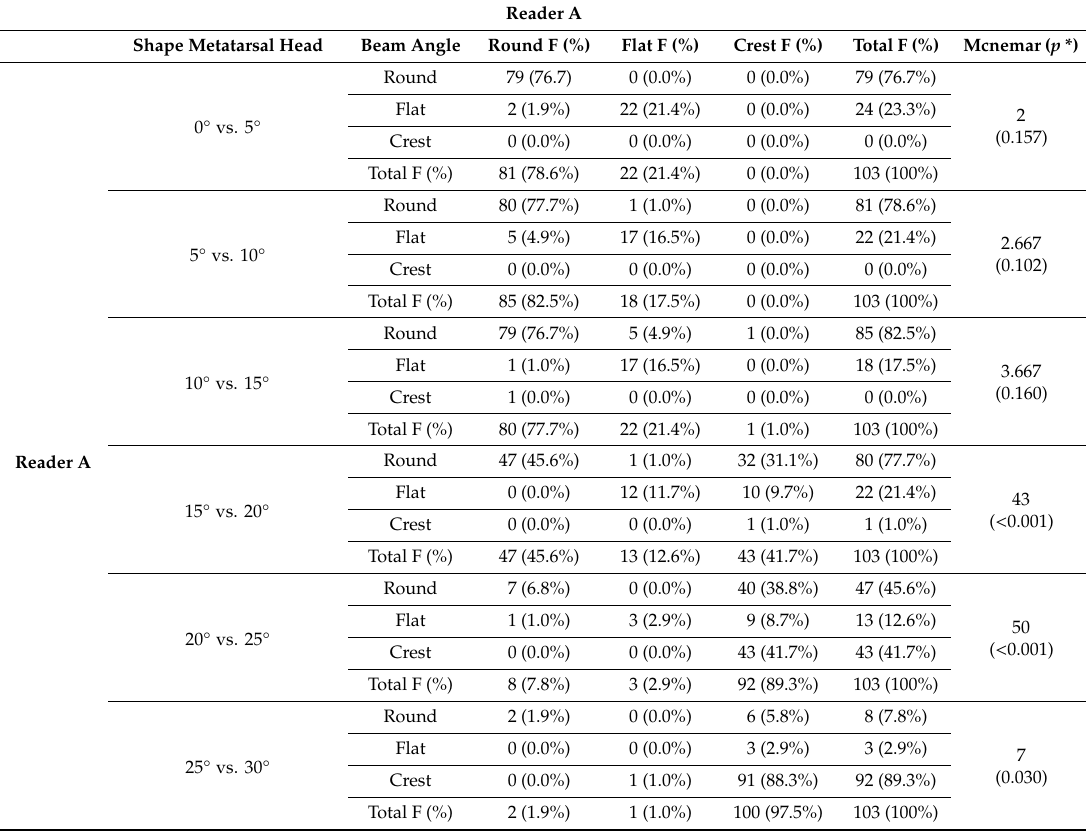
Table 2. Intraobserver A agreement about shape first metatarsal head in beam angle: 0 ◦ vs. 5 ◦ , 5 ◦ vs.